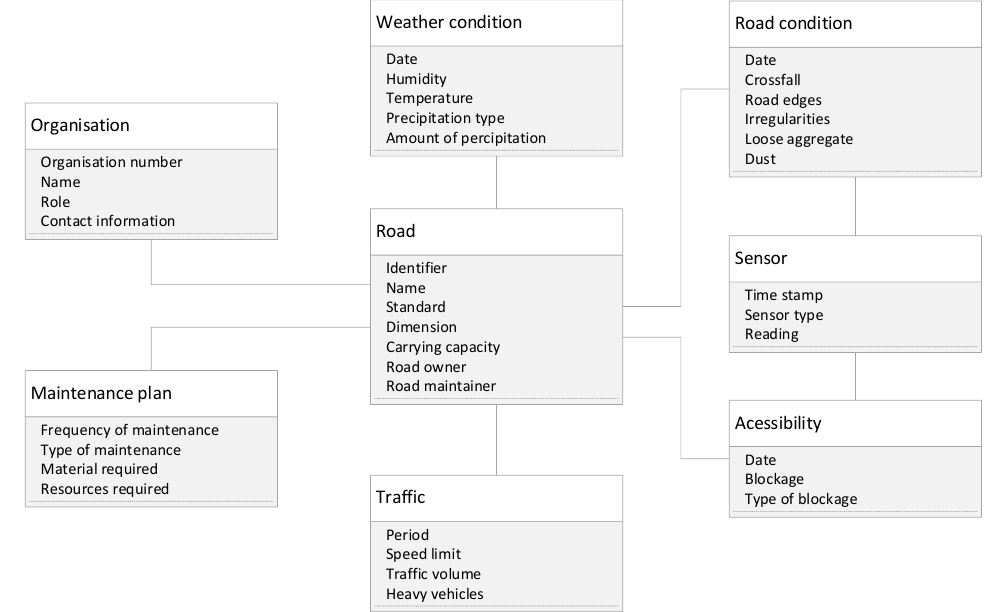
Figure 2. Proposed information